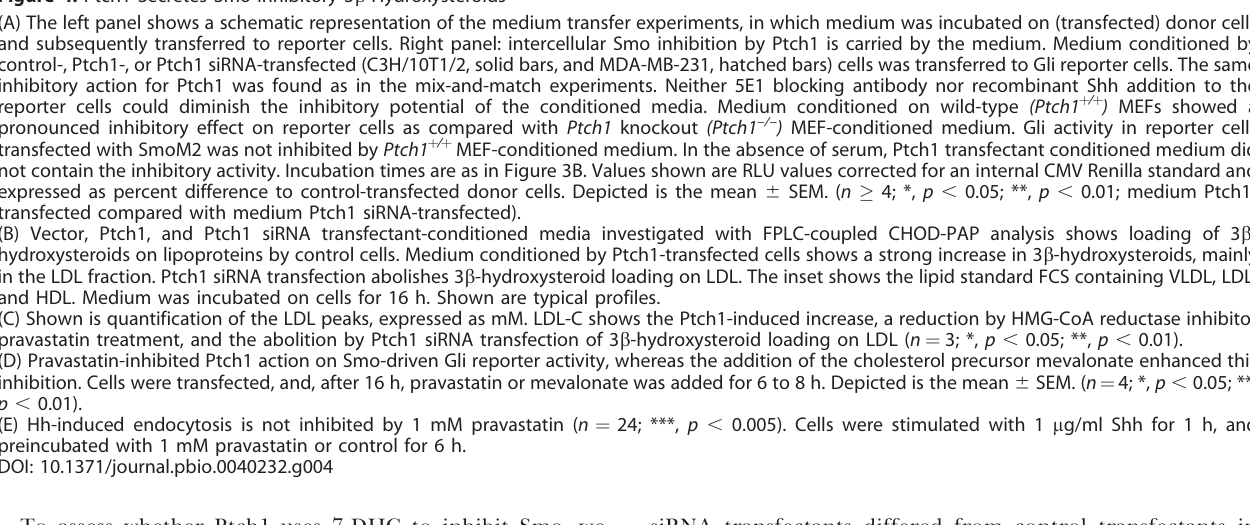
Figure 4. Ptch1 Secretes Smo-Inhibitory 3 b